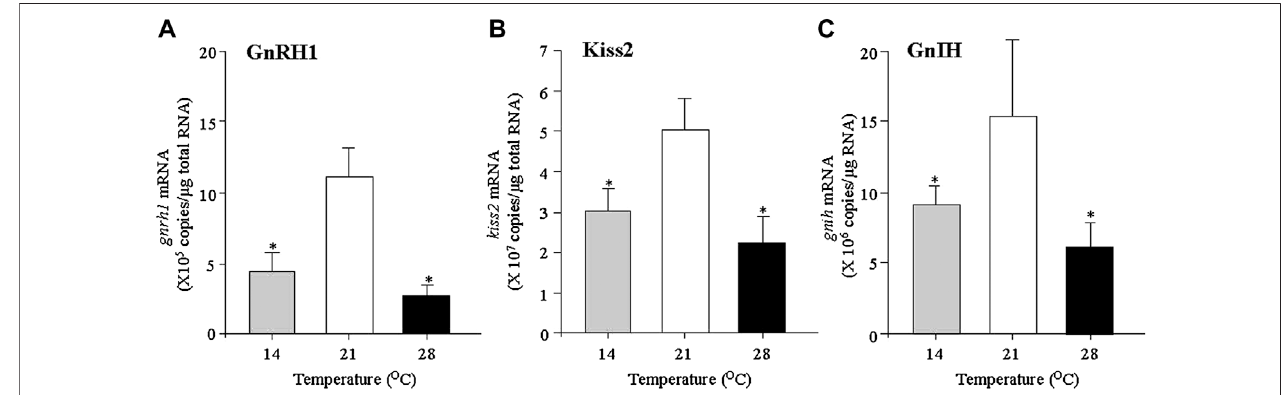
FIGURE 1 | Changes in the expression levels of gnrh1 (A) , kiss2 (B) and gnih (C) in the diencephalon of grass puffer exposed to low temperature (14 ° C), normal temperature (21 ° C) and high temperature (28 ° C) conditions for 7 days. Values are presented asmean ± standard error of the mean (SEM) (n = 8 in each group). Asterisk indicates a signi fi cant difference in the low and high temperature groups compared to the normal temperature group (*, p <